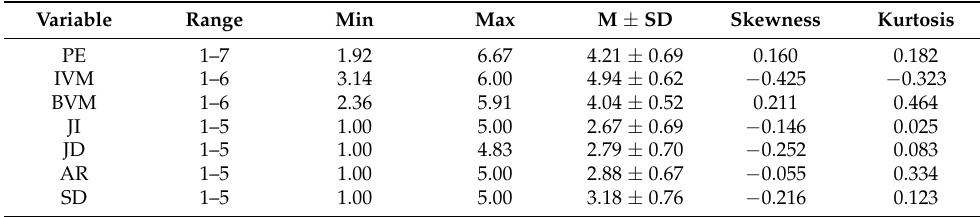
Table 2. Descriptive statistics of the variables.